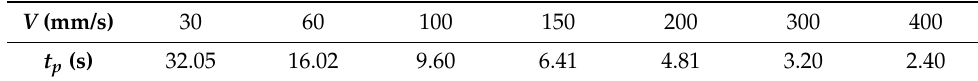
Table 1. Pressure holding time of 1 N/mm laying pressure probe test.